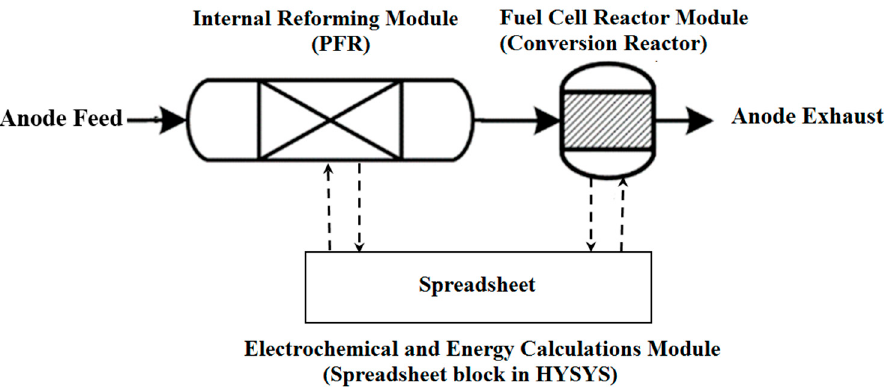
Figure 1. Schematic of integration of the internal reforming reaction modules and the fuel cell reactor module.